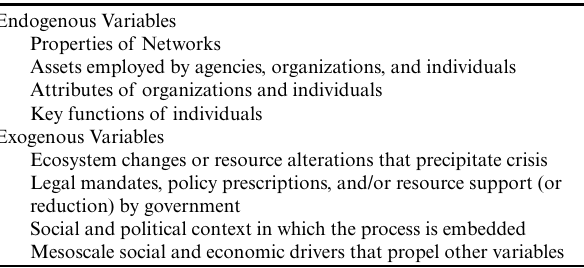
Table 3 . Categories of variables identified by Plummer (2009) as being potentially important to understanding dynamic social processes in ollaborative adaptive